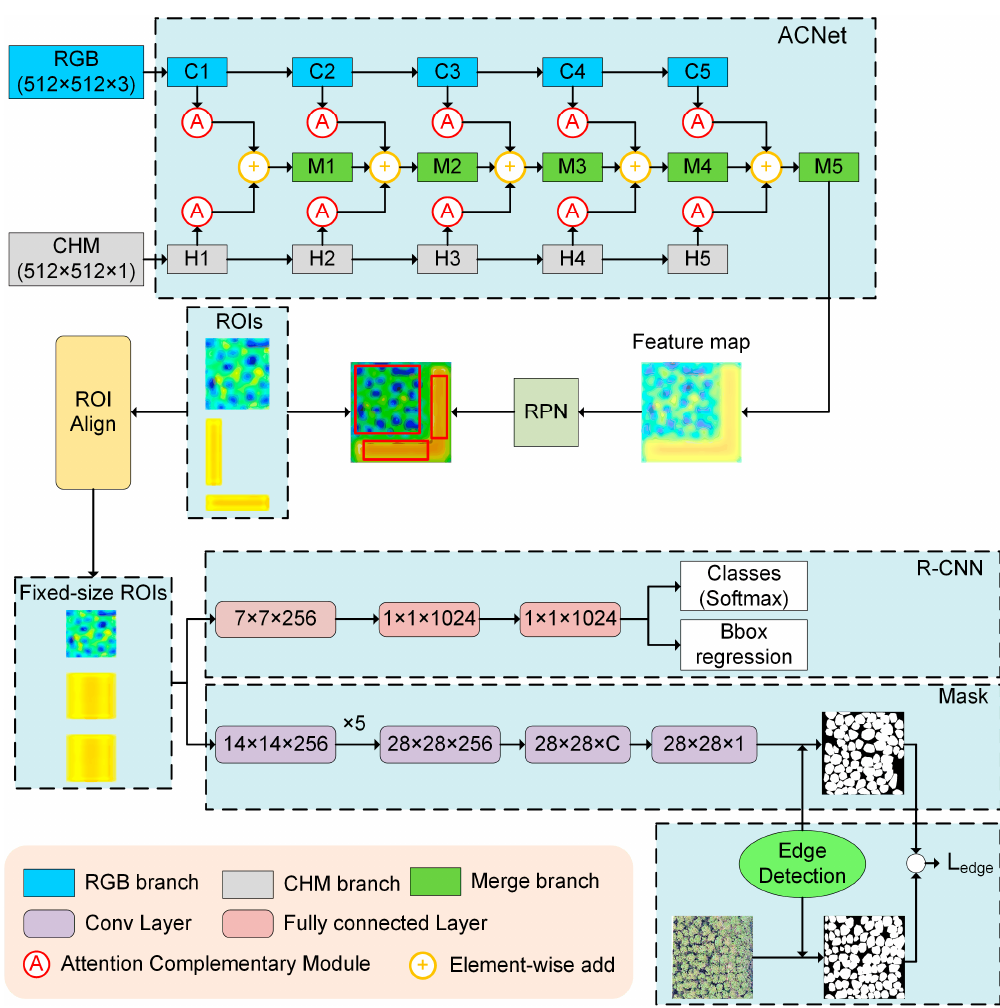
Figure 4. The framework of our proposed ACE R-CNN. Table 3. The specific parameters of the ACNet network